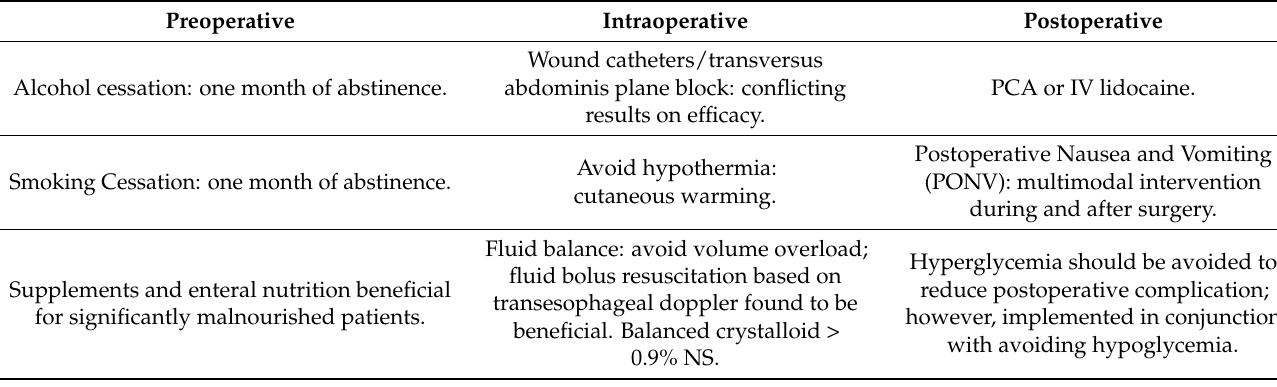
Table 1. ERAS recommendations for pancreaticoduodenectomy